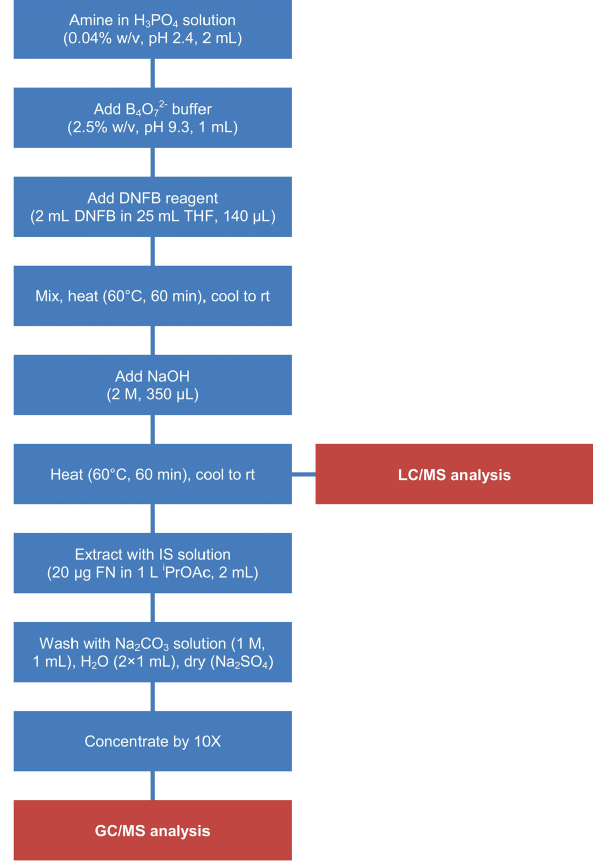
Fig. 3. Flowchart summary of the amine derivatization proce- dure. H 3 PO 4 , phosphorous acid; B 4 O 2 − , sodium tetraborate dec- 7 ahydrate; DNFB, 2,4-dinitrofluorobenzene; NaOH, sodium hy- droxide; IS, internal standard; FN, 1-fluoronaphthalene; i PrOAc, iso -propyl acetate; Na 2 CO 3 , sodium carbonate; Na 2 SO 4 , sodium sulfate.